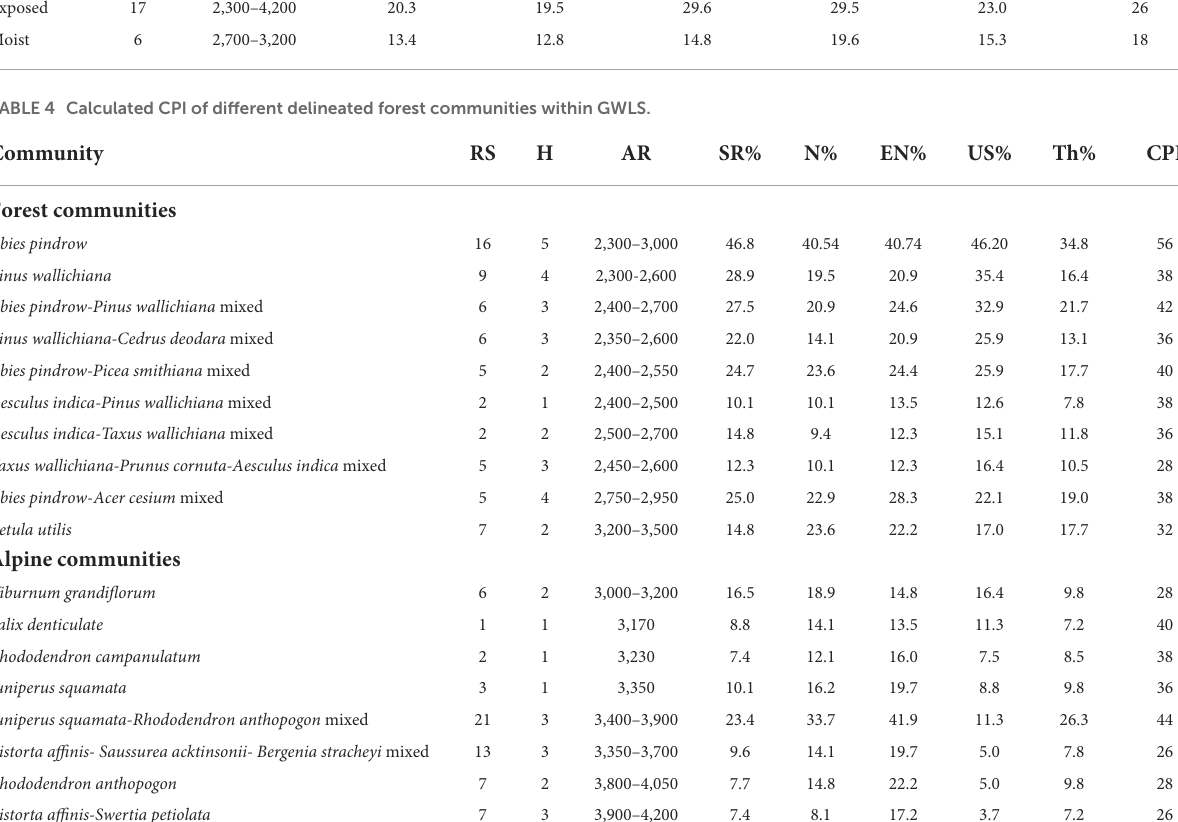
TABLE 4 Calculated CPI of different delineated forest communities within GWLS. Community